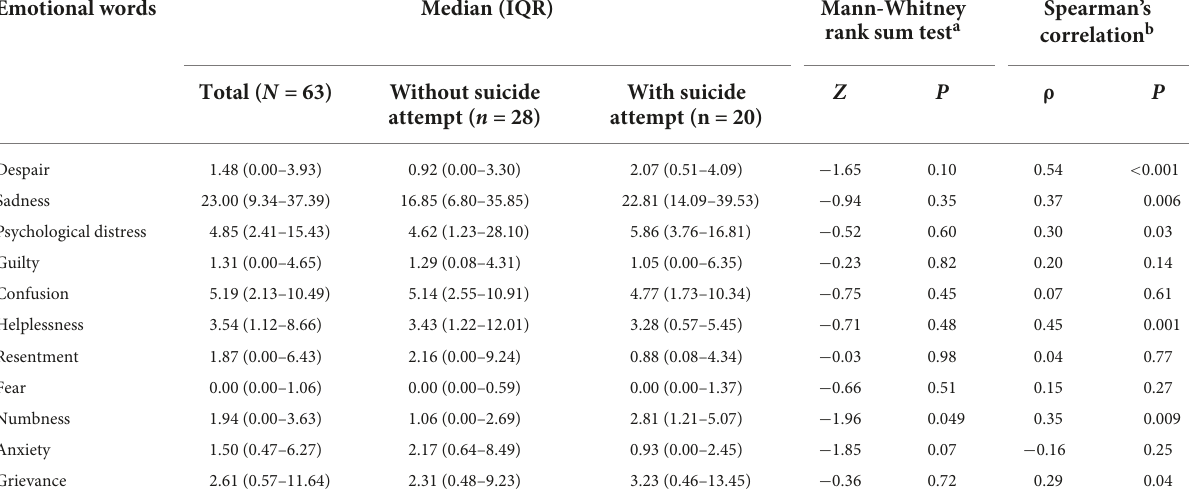
TABLE 3 Criterion validity analysis of the indices of 11 suicide-related emotional words in the EWLSRA. Emotional